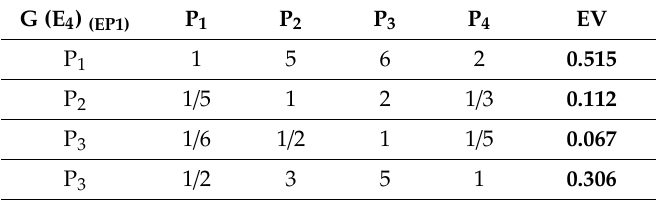
Table 4. Pairwise comparison and EV values of P 1 , P 2 , P 3 and P 4 by expert 1 targeting target G (E 4 ).